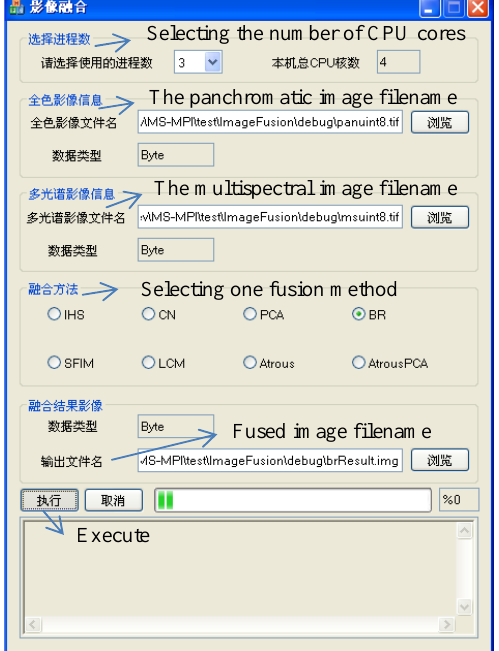
Fig. 3 The developed software